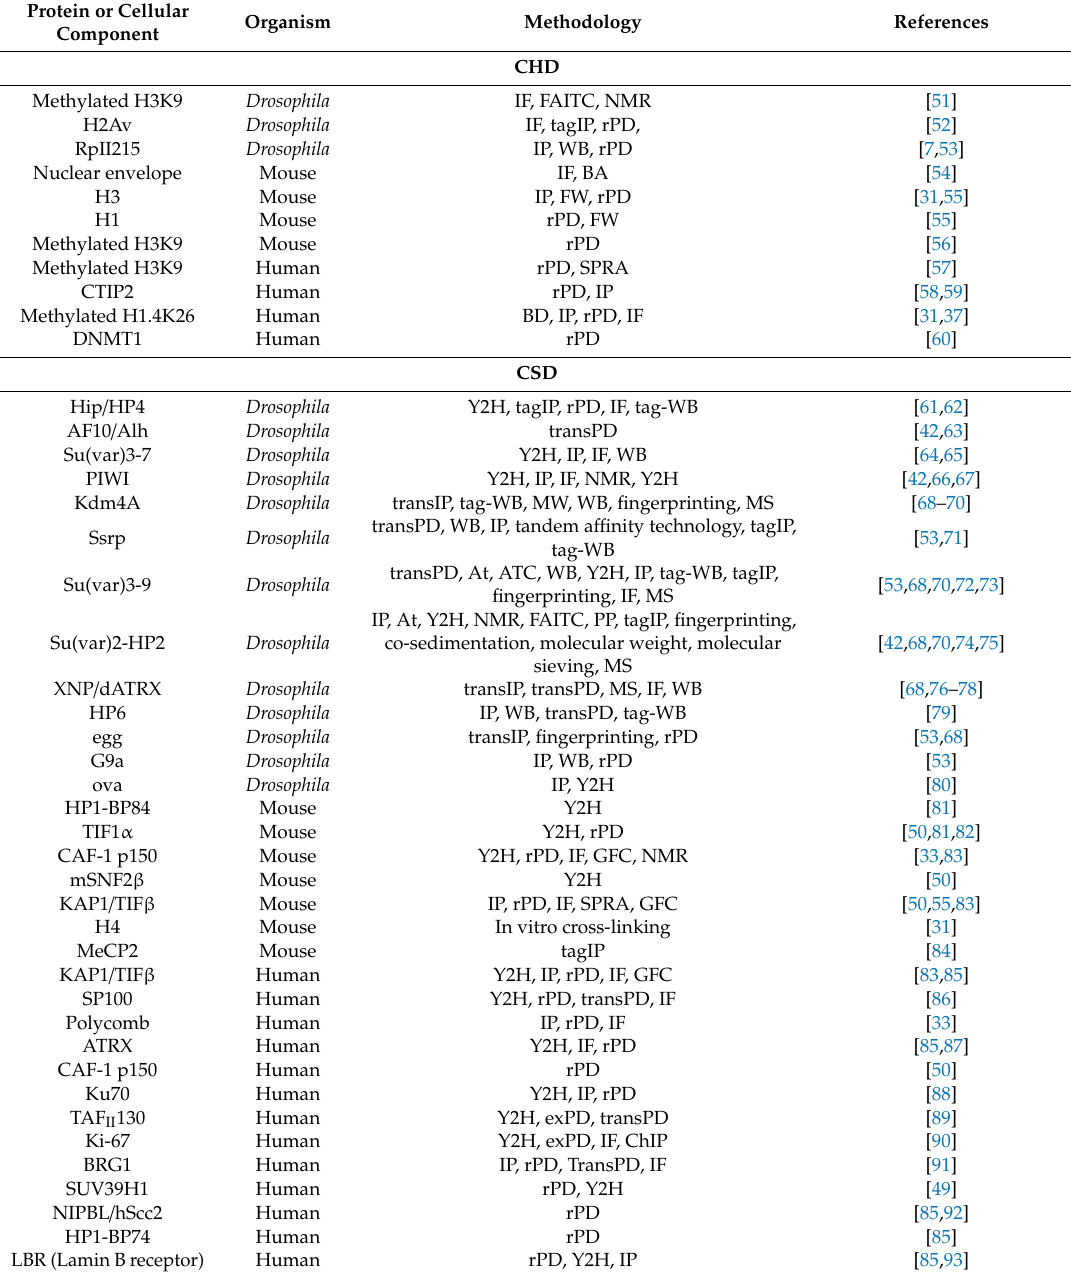
Table 1. Proteins or factors in mammals and Drosophila that were revealed as directly bound with the known domains of HP1a / HP1 α